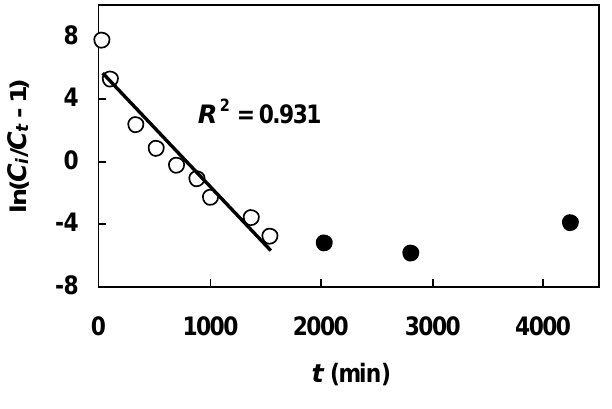
Table 6. Parameter estimation in the Bohart-Adams equation by the linear regression, nonlinear regression and GA methods.